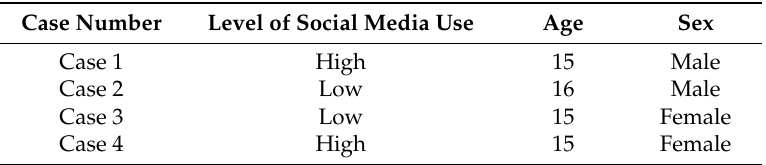
Table 1. Characteristics of case